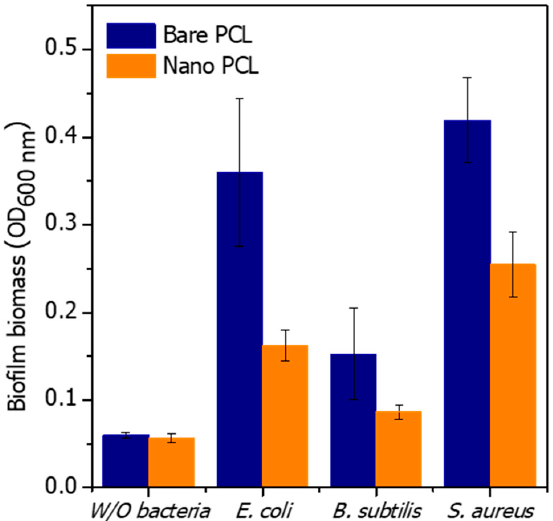
Figure 7. Biofilm biomass assessment on the PCL samples with crystal violet.